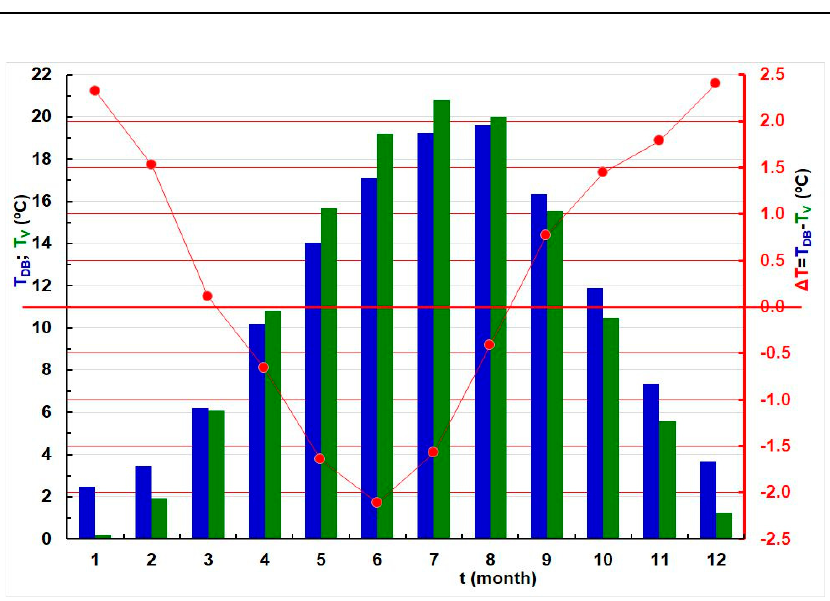
Figure 6. Histograms of the average monthly water temperatures of the Drava at the Botovo station (blue color), T DB , and the air temperatures of Varaždin (green color), T V , with a line graph of their differences (red color), Δ T = T DB − T V , from 1969–2021.